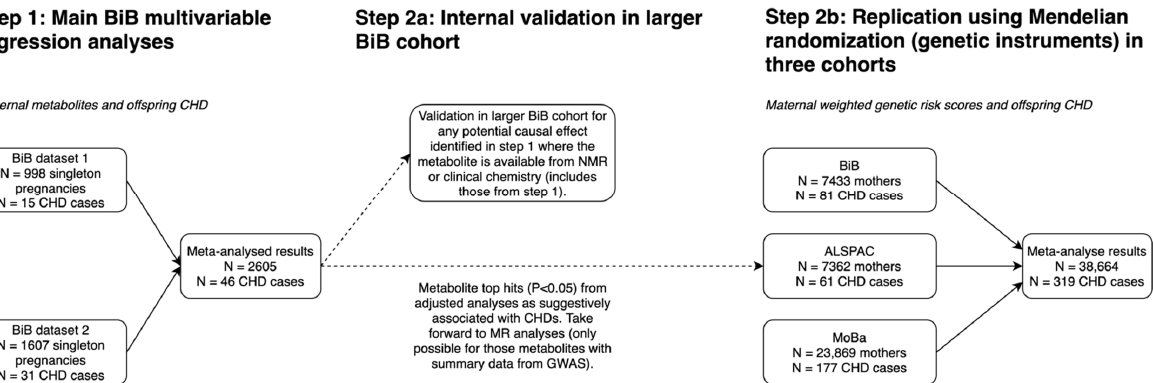
Figure 1. An overview of the study design. BiB has pregnancy mass spectrometry derived metabolomics in two separate datasets. Dataset 1 was completed in December 2017 and included 1000 maternal pregnancy samples. Dataset 2 was completed in December 2018 and consisted of 2000 maternal pregnancy samples within a case cohort design. The selection of participants into the two MS metabolomic datasets are shown in flowcharts in Figure S1. Abbreviations: CHD, congenital heart disease; BiB, Born in Bradford; NMR, nuclear magnetic resonance; MR, Mendelian randomization; GWAS, genome-wise association study; ALSPAC, Avon Longitudinal Study of Parents and Children; MoBa, Norwegian Mother, Father and Child Cohort.